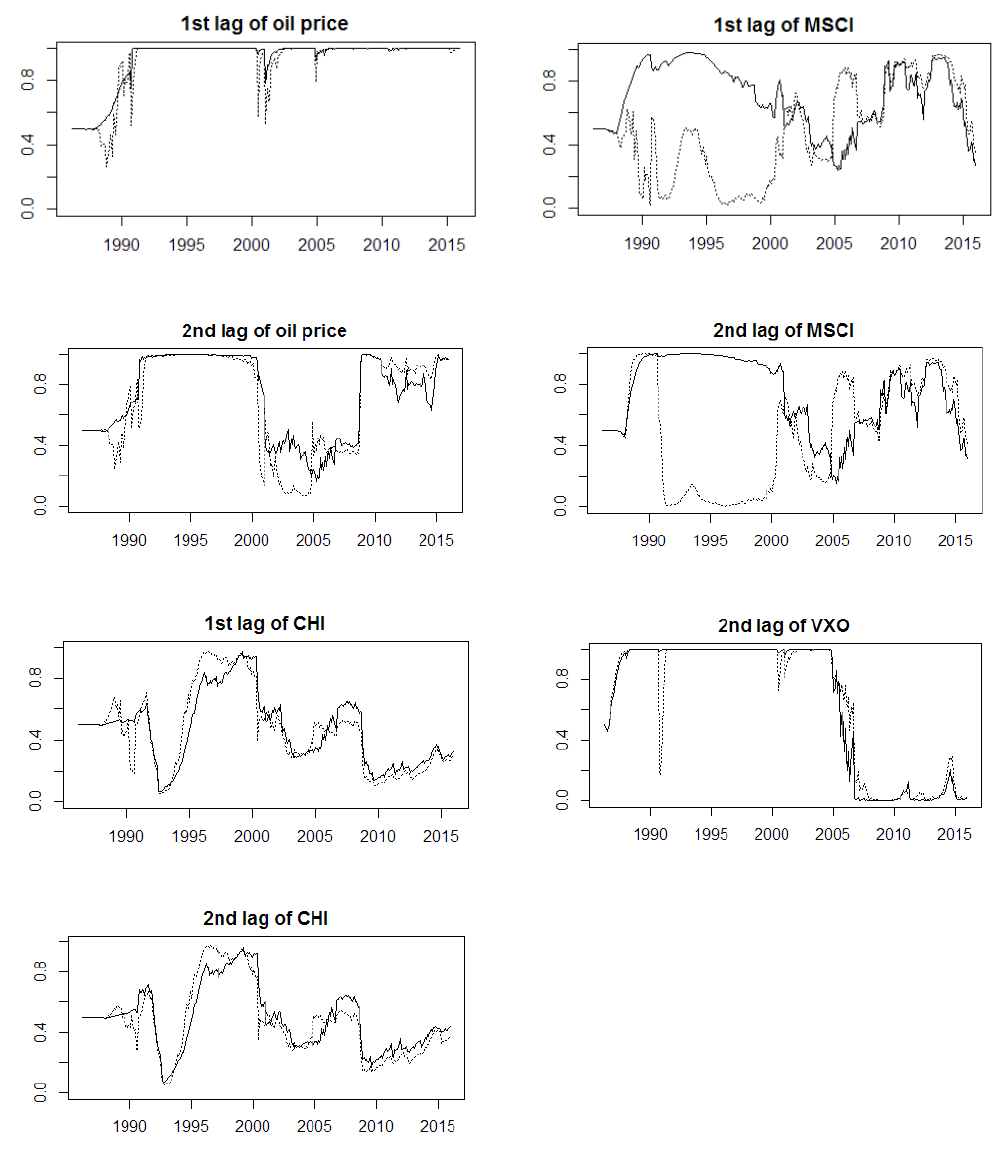
Figure 4. Posteriori inclusion probabilities p t for drivers included in Model 5 (normalized, “reduced”, α = 0.99). Thick line corresponds to model with WTI, dotted—to model with BRENT.